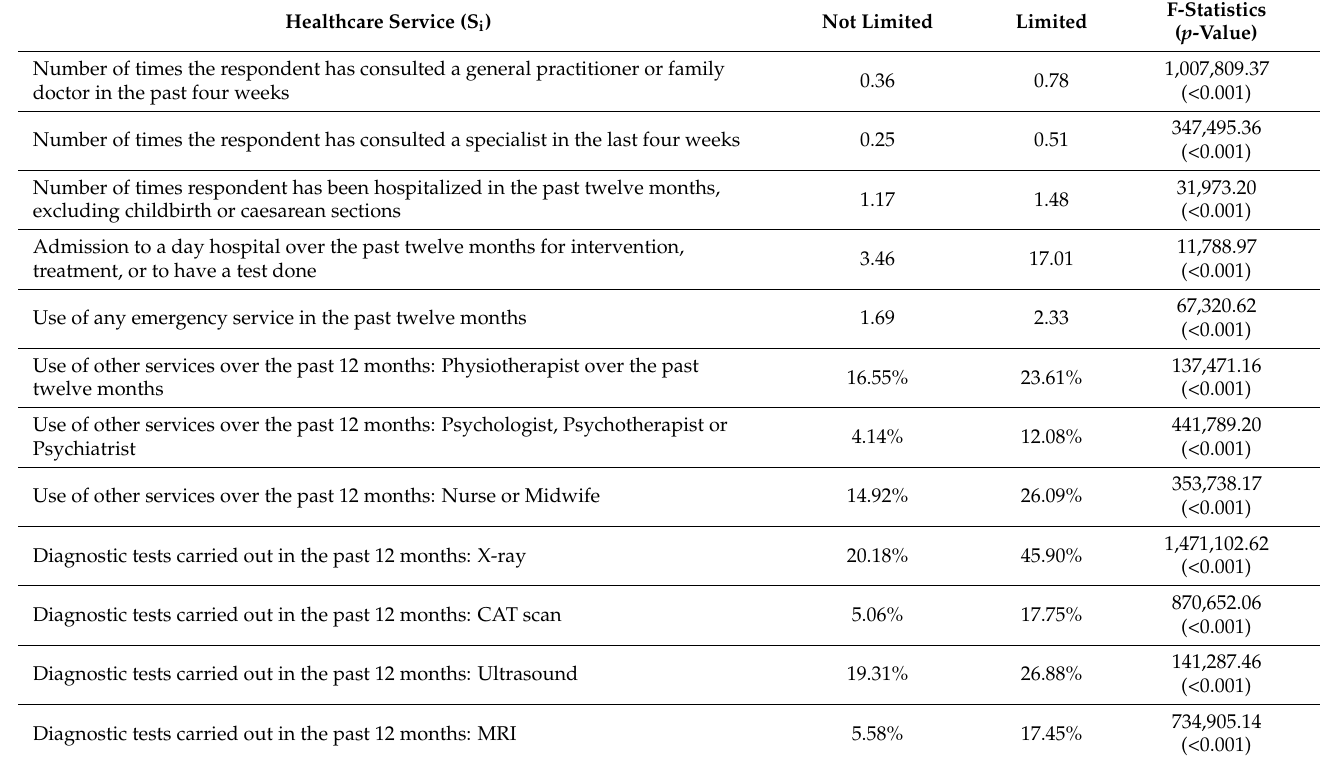
Table 5. Use of healthcare services by group of